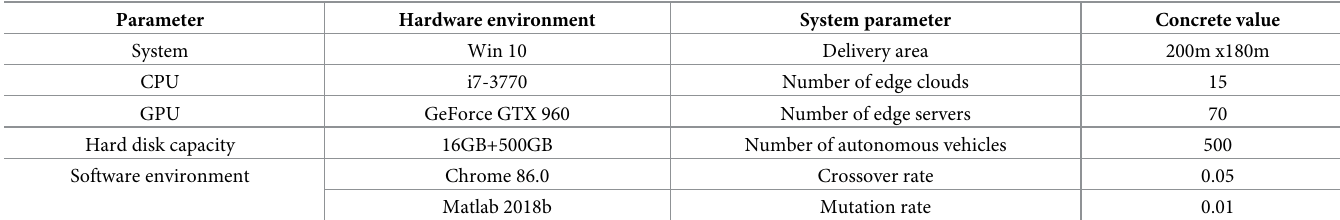
Table 1. Experimental environment and specific parameters of cloud computing.